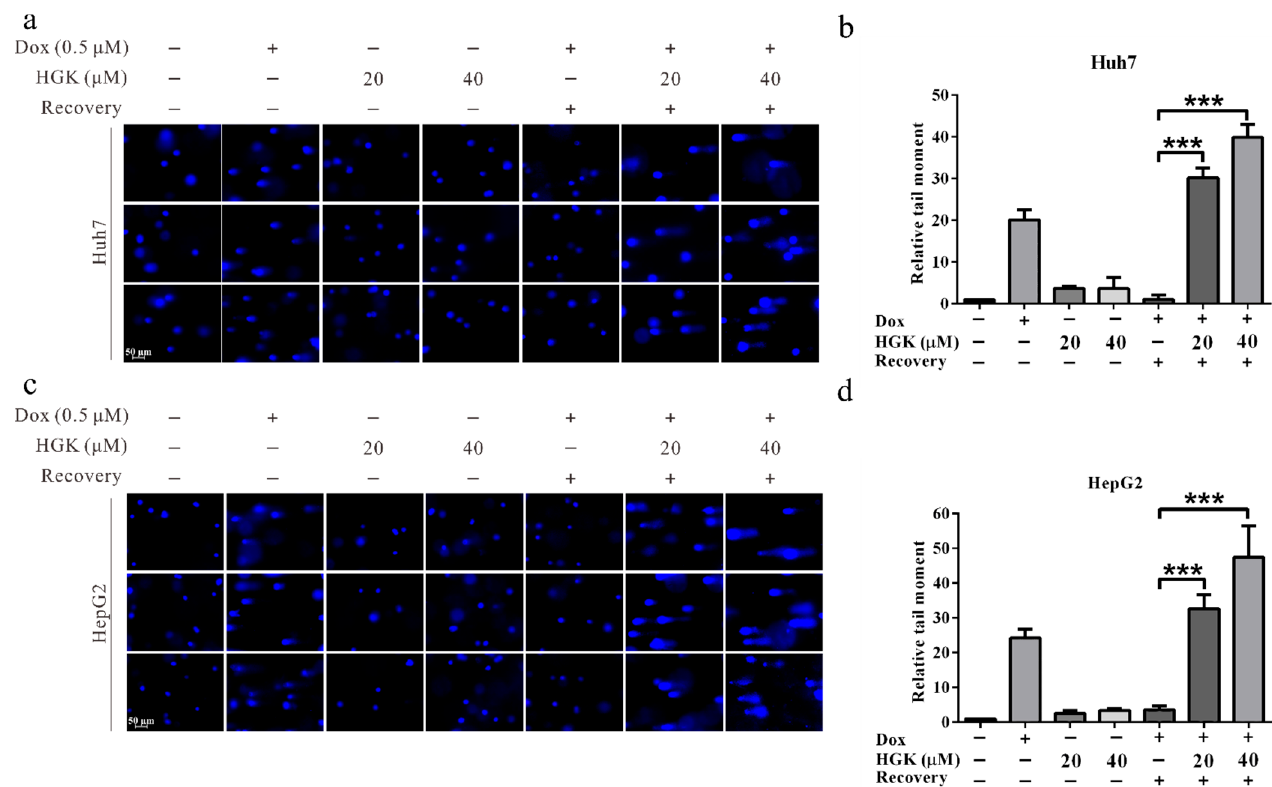
Figure 2. Hydroxygenkwanin (HGK) inhibits the DNA damage repair ability of hepatocellular carcinoma cell lines. ( a , c ) Huh7 and HepG2 cells were treated with 0.5 µ M doxorubicin for 1 h, followed by treatment with different concentrations of HGK in doxorubicin-free medium for 4 h. The cells were harvested and subjected to alkaline denaturing comet assay to assess the DNA repair activity. ( b , d ) Quantitative DNA damage repair activity of the cells, p < 0.001 (***). All data were expressed as mean ± standard deviation values obtained from three independent experiments.